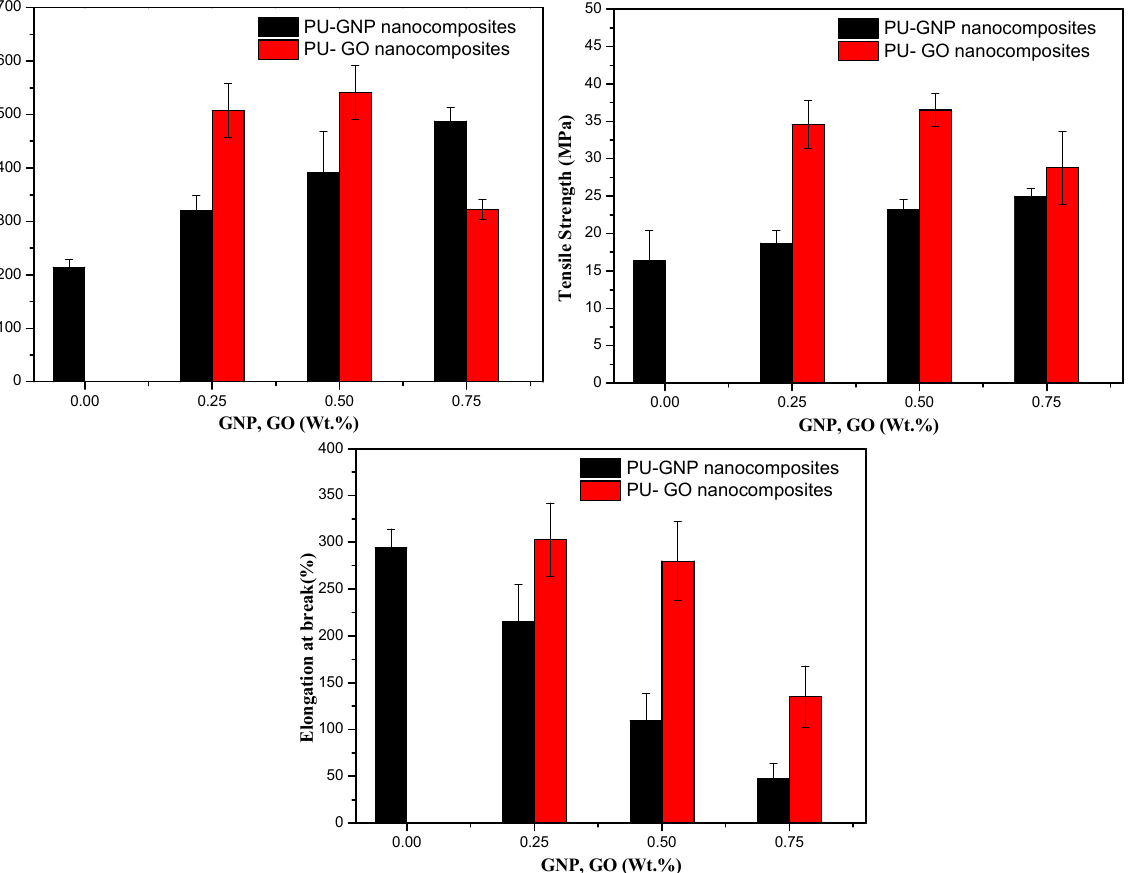
Figure 10. Comparative mechanical properties of the PU/GNP and PU/GO nanocomposites.